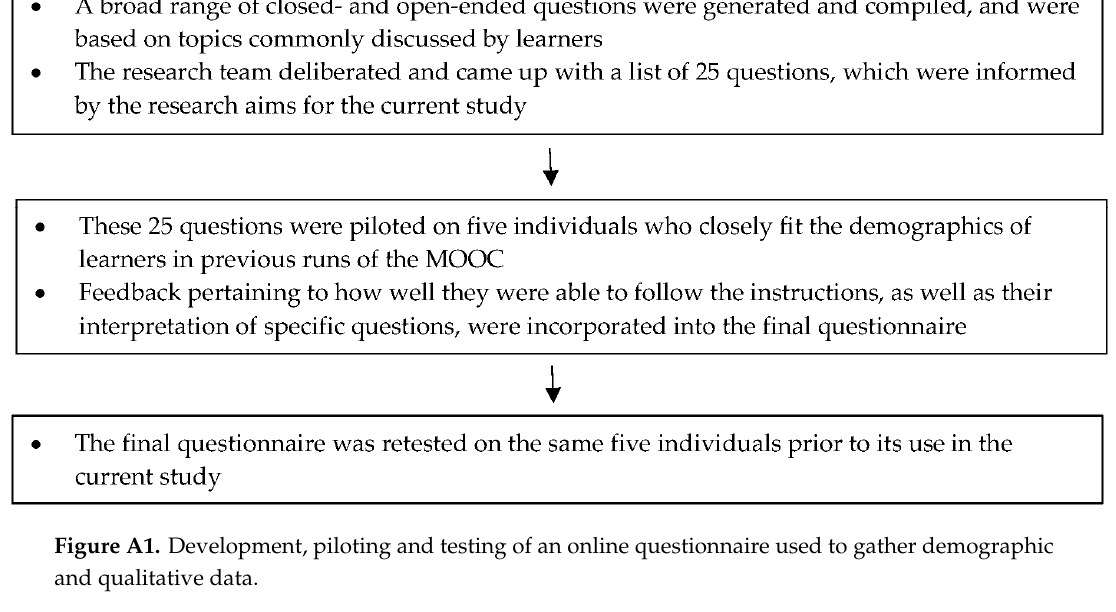
Figure A1. Development, piloting and testing of an online questionnaire used to gather demographic and qualitative data.